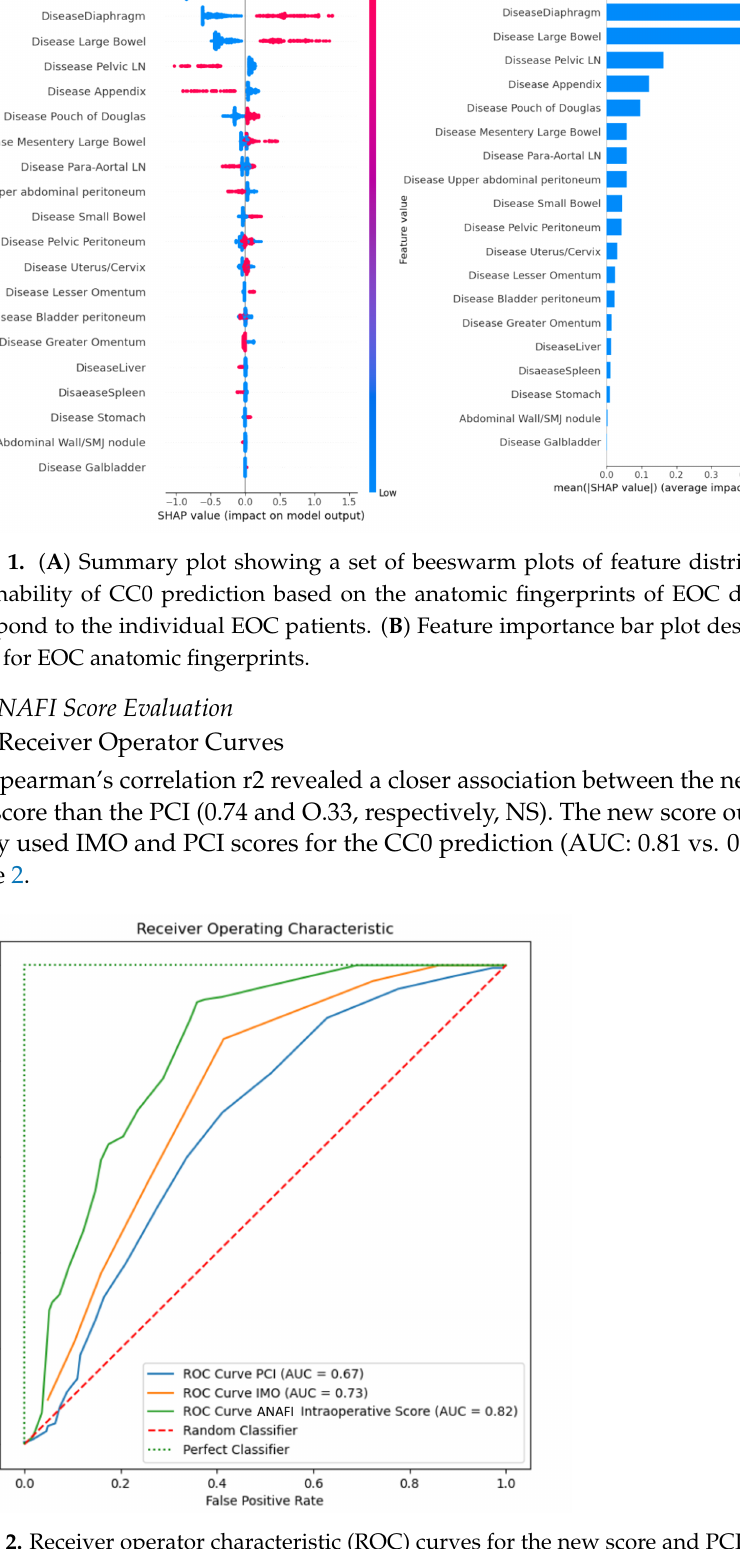
Figure 2. Receiver operator characteristic (ROC) curves for the new score and PCI and IMO scoring systems, showing the estimated probability for complete cytoreduction (CC0). The novel intra- operative disease score based on the weighted EOC anatomic fingerprints can be more discriminant than the existing scores for CC0